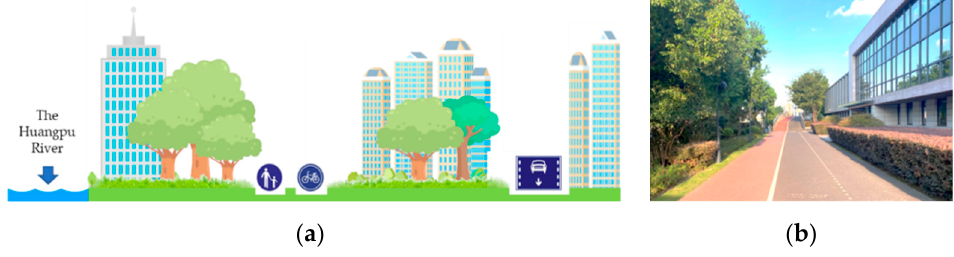
Figure 4. The mixed form of greenway along the Huangpu River in Shanghai (mixed greenway), seen from the perspective of ( a ) greenway designer and ( b ) greenway user, combines the characteristics of natural and built greenways, which are integrated into the urban landscape as part of the daily infrastructure with which residents interact. They integrate the ecological benefits of green plants into the built-up areas of cities as much as possible, so that residents can enjoy the conveniences offered by modern cities, concurrently also experiencing the feeling of returning to nature.